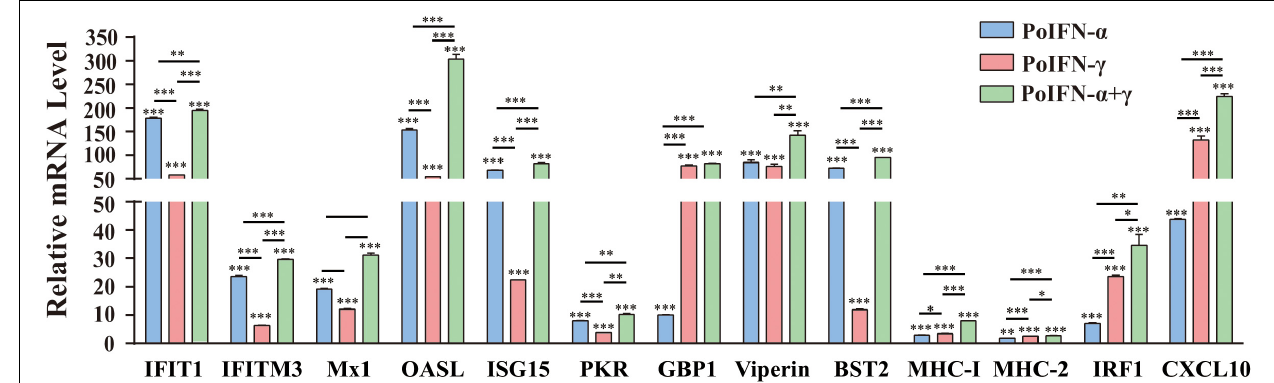
FIGURE 2 | Gene expression in primary alveolar macrophages (PAMs) induced with PoIFN- α and PoIFN- γ . Fresh PAMs were isolated from healthy 35-day-old pigs and cultured in RPMI 1640 medium with 10% FBS and 5% CO 2 for 12 h. Then, the cells were treated with PoIFN- α or PoIFN- γ for 12 h. After the 12 h, the cells were harvested and lysed in TRIzol Reagent for RNA extraction. The vertical axis shows the relative transcription level (fold-change) of IFN-stimulated gene (ISG) expression comparing the negative control and treated groups. The fold-changes were measured by the 2 − (cid:49)(cid:49) Ct method, and RNA levels were normalized. Three replicates were performed for q-PCR verification analyses. Bars represent the means ± SDs ( n = 3). A non-parametric test was used for the difference significance analysis. Statistically significant differences are indicated ( ∗ P < 0.05; ∗∗∗ P < 0.01; ∗∗∗ P < 0.001) and the line above the column marks the two groups with differences.